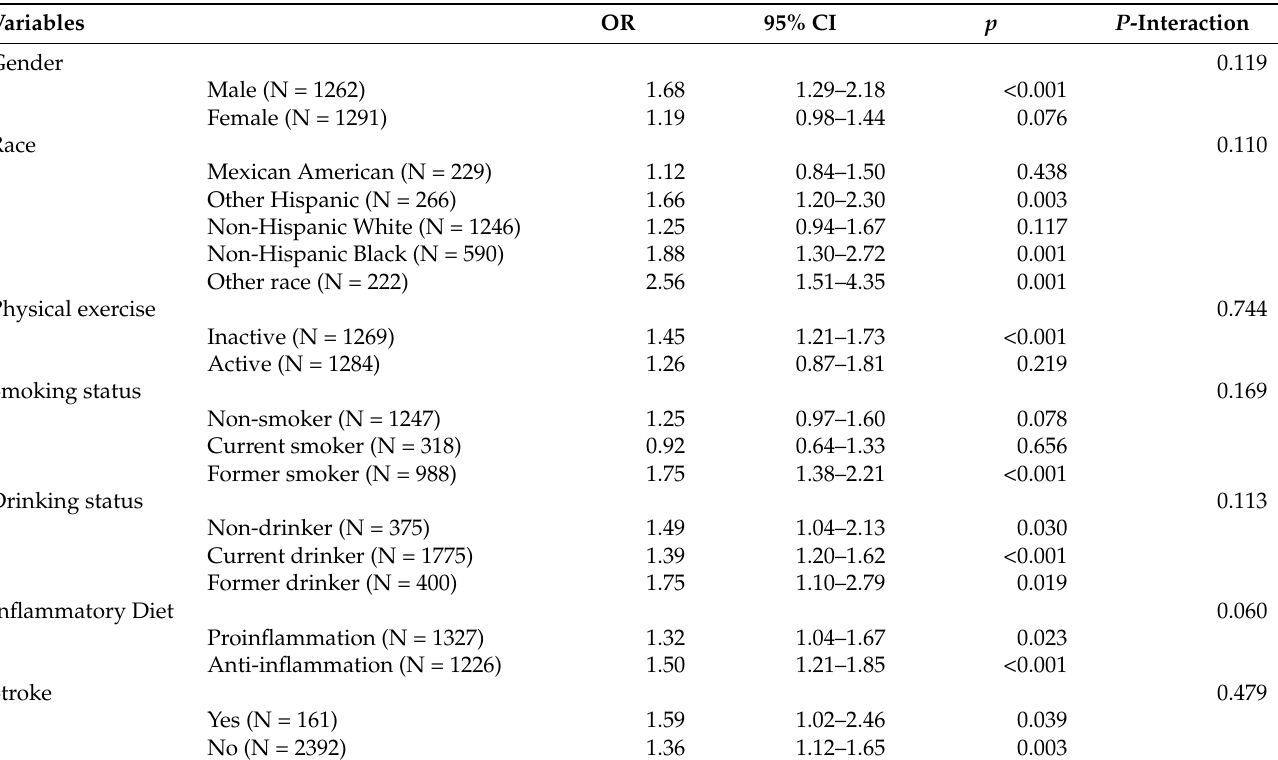
Table 3. Stratified analyses of the associations between cognitive impairment level and depressive